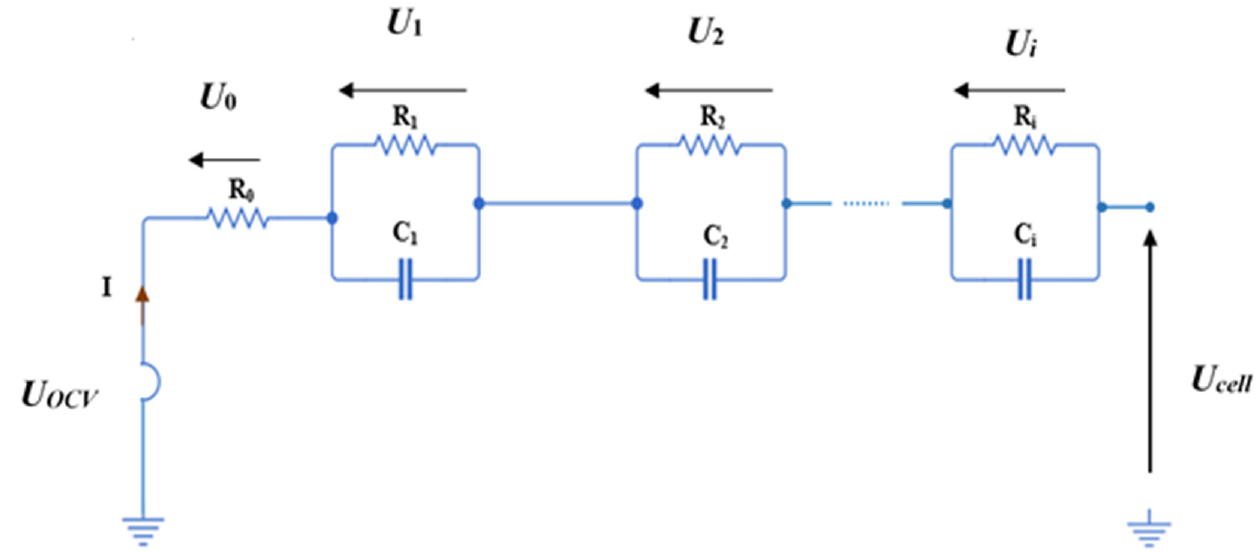
Figure 1. Diagram of the i-order RC battery model.